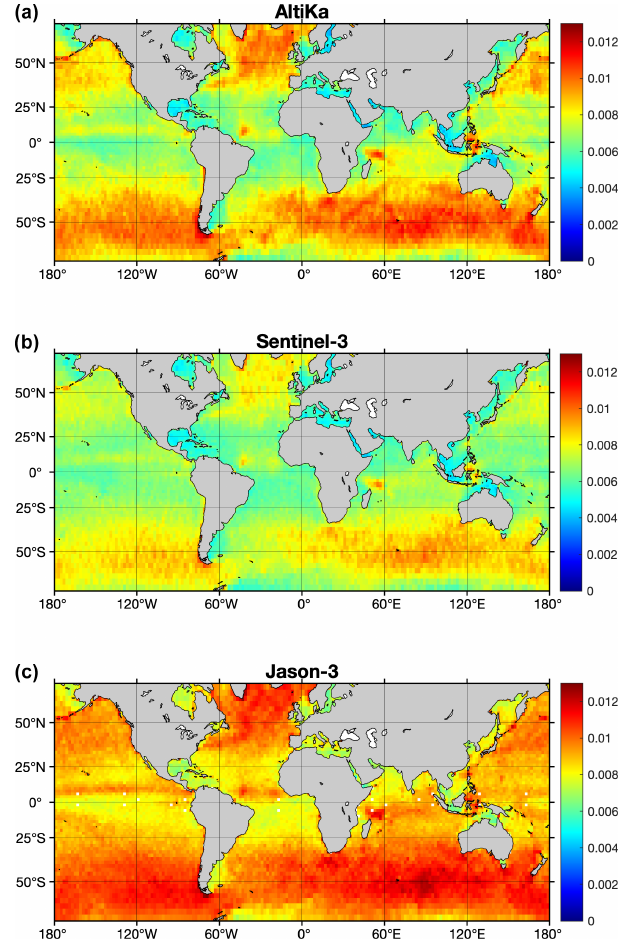
Figure 10. Three-year mean value of ε (m) for AltiKa (a) , Sentinel- 3 (b) , and Jason-3 (c)